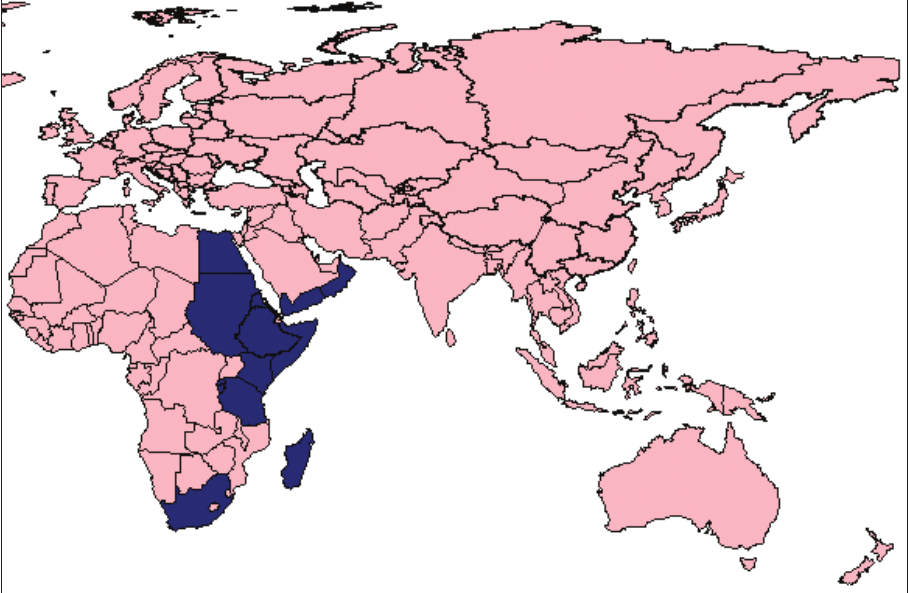
Figure 15. Map of the known country records of Pycnodictya galinieri galinieri.